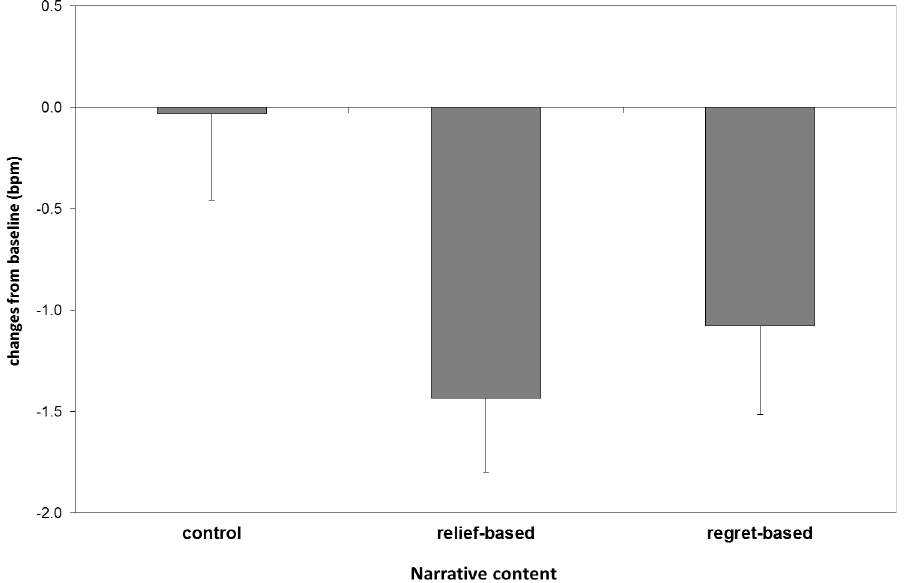
Fig 3. Heart rate. HR decreases during narrative reading as a function of narrative content.